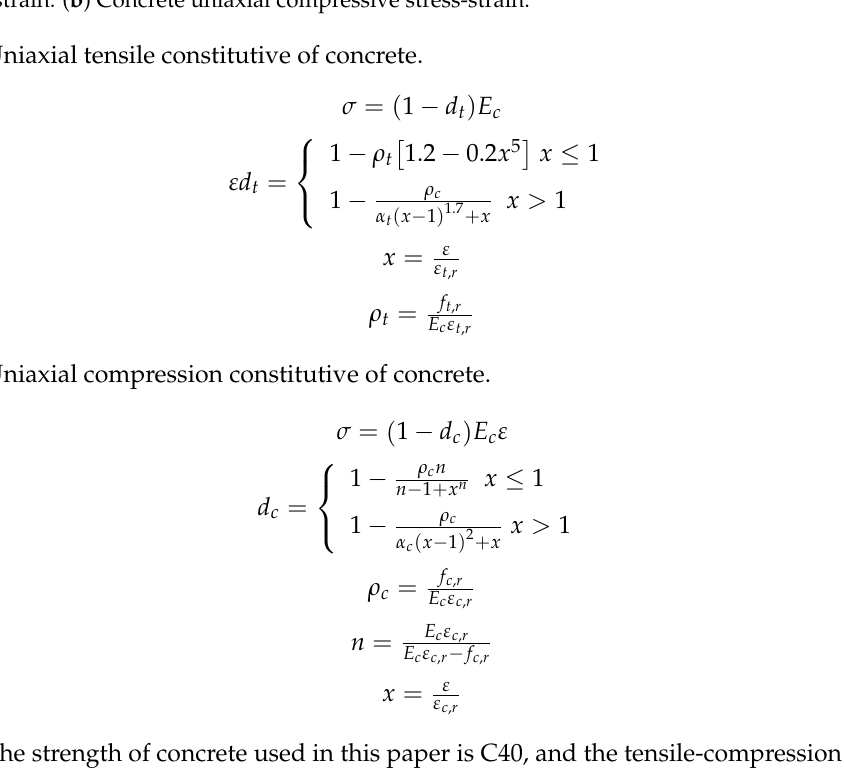
Figure 16. The tension and compression stress-strain curve of concrete. ( a ) Concrete uniaxial tensile stress-strain. ( b ) Concrete uniaxial compressive stress-strain.